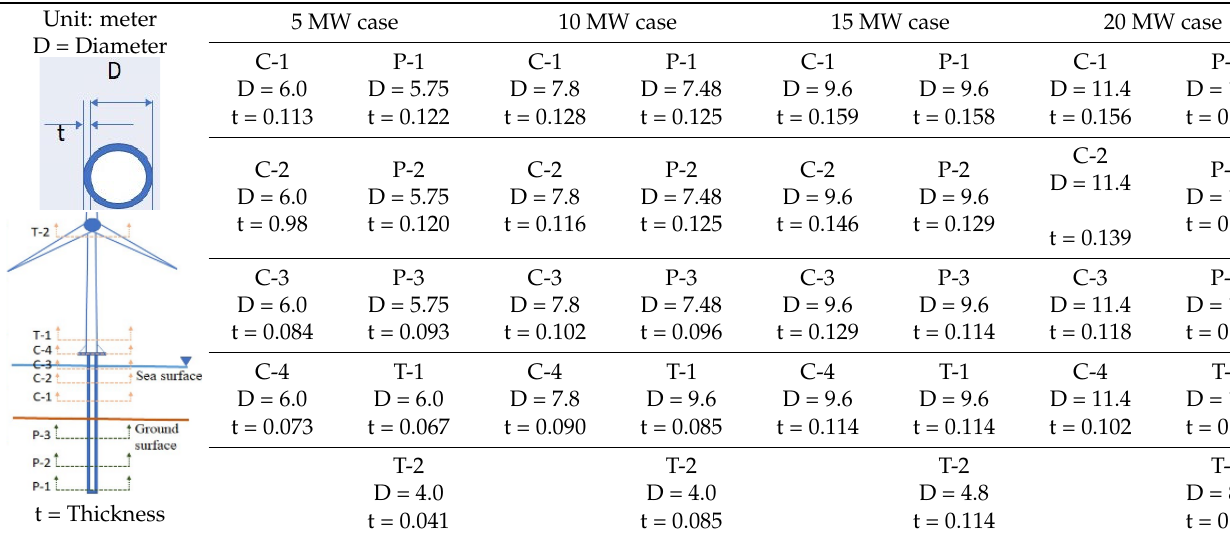
Table 3. The section properties of the 5, 10, 15, and 20 MW OWT support structures used in Section 3.2 (C = column, P = pile, and T = tower as shown in Figure 3).